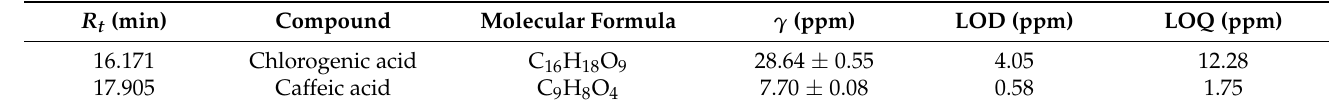
Figure 1. The HPLC chromatograph (325 nm) of the aqueous extract of A. annua . Table 1. Retention time ( R t ), molecular formula, and the concentration of the phenolic compounds in the studied A. annua aqueous